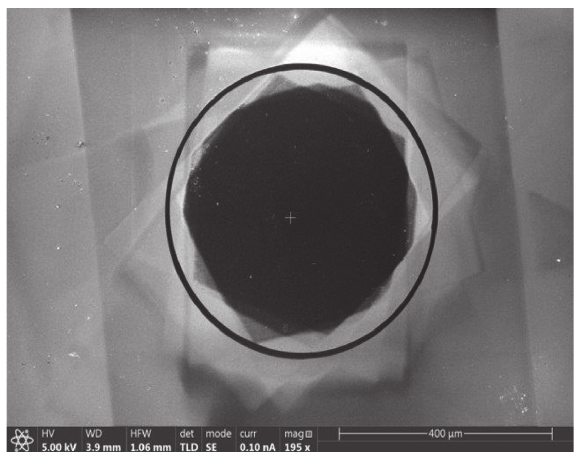
Figure 1: SEM image of silicon substrate after spin-mill processing for oxide and debris removal.